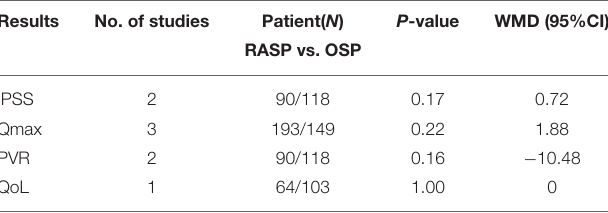
TABLE 3 | Overall analysis of post-operative efficiency parameters comparing RASP and OSP.